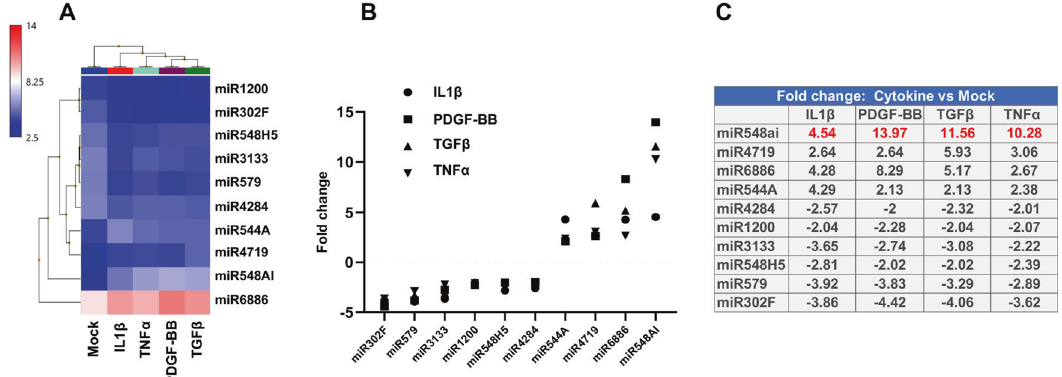
Fig. 3 microRNAs that are commonly up- or down-regulated by all four cytokines. The AoSMC-derived microRNAs that were commonly up- or down-regulated by all four cytokines were selected (from the data in Fig. 2), and the data are presented as heatmap ( A ), plot ( B ), or table of fold changes ( C stimulants in the blood. However, upon the angioplasty proce- We used four different cytokines to induce SMC dysfunction dure, this protective EC barrier is broken, and SMCs are abruptly and then performed unbiased screening through microRNA exposed to various cytokines (typically PDGF-BB, TGF β 1, TNF α , and pro fi ling to extract the information of common microRNAs that IL1 β ) which stimulate SMCs phenotypic changes and hence loss of were responsive to all four cytokines. In normal conditions, the ECs its innate functions [26]. In this light, we envisioned that the use of that line the inner vessel wall keep SMCs insulated from adverse